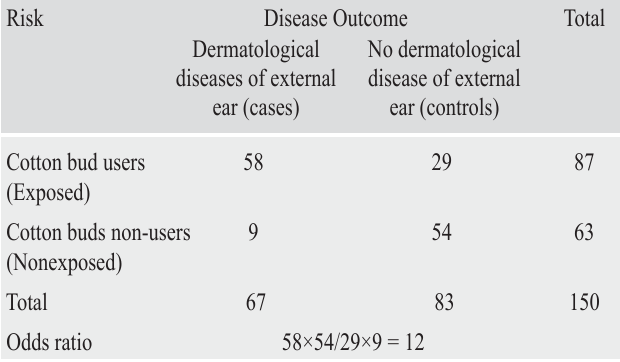
Table I: Risk of use of cotton buds of external ear Risk Disease Outcome